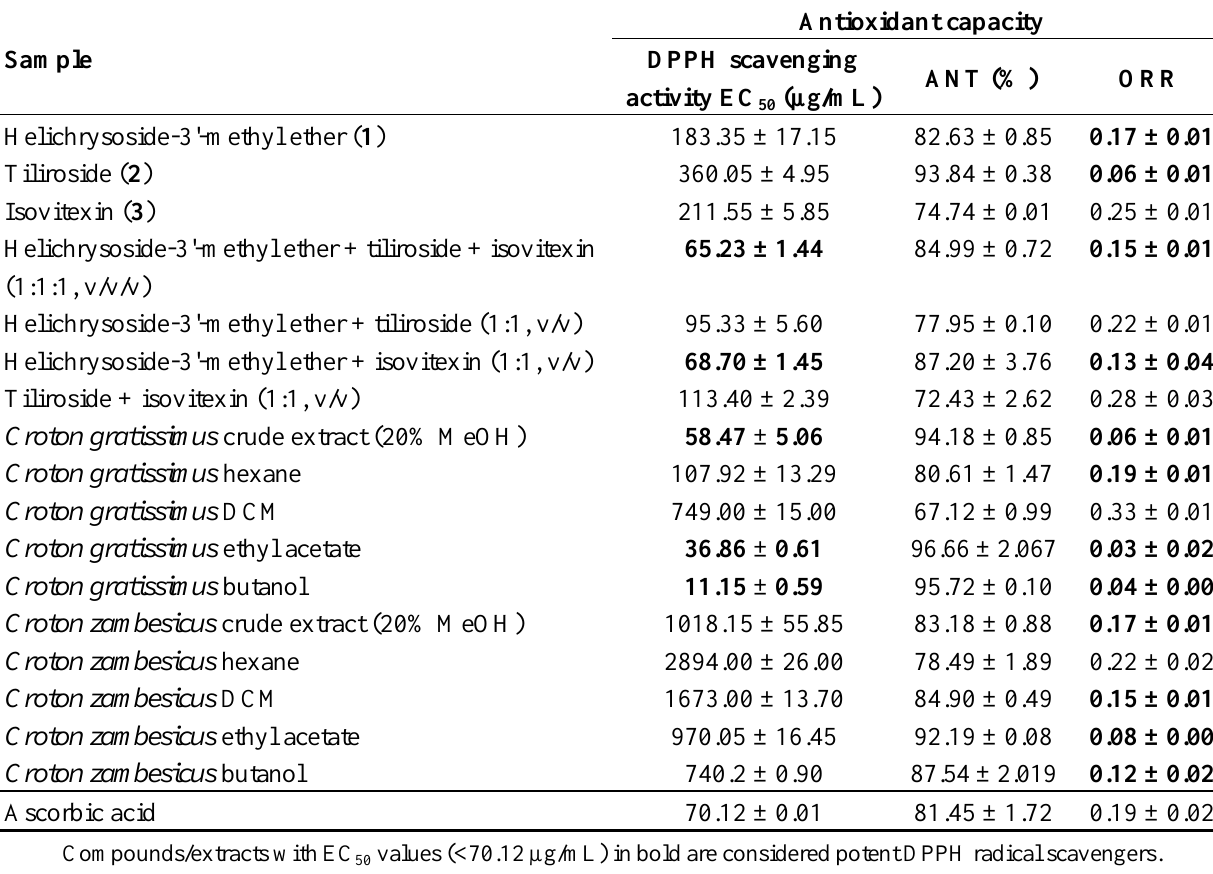
Table 1. Antioxidant activity as determined by the DPPH scavenging assay and β -carotene-linoleic acid model system of the isolated compounds, crude extracts and fractions from C. gratissimus and C. zambesicus . n =